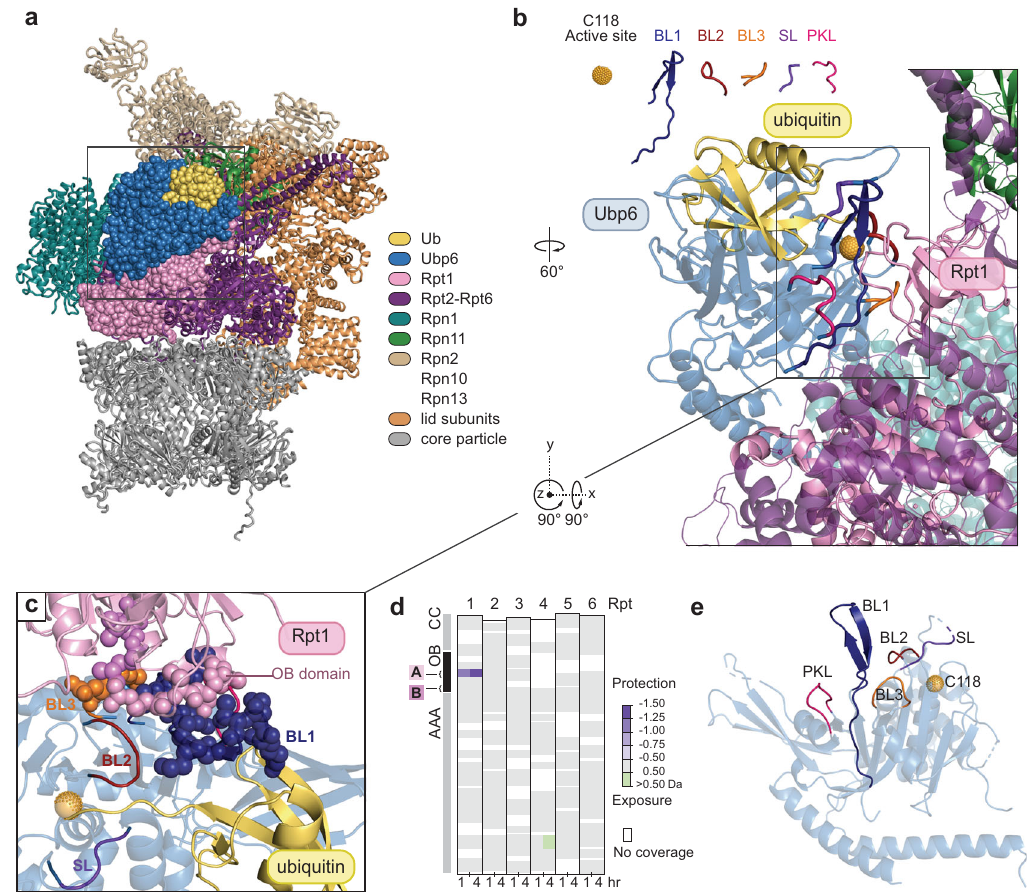
Fig. 1 Model of the Ubp6-Rpt1 interface. a Model of the Ubp6-UbVS-proteasome complex based on cryo-EM analysis. Ubp6, Rpt1, and ubiquitin are highlighted as spheres, other proteins as ribbons. Rpn1, teal; Rpn11, green; Rpn10 and other base subunits, tan; lid components, light brown; ATPases other than Rpt1, purple; core particle, gray. Boxed region is rotated and enlarged in b . (PDB: 7QO3, 7QO4). b Detail of Ubp6-Rpt1 interface with key features of Ubp6 highlighted. c Enlarged underside view of the Ubp6-Rpt1 interface with mutagenized residues rendered as spheres. Interface A is in blue for Ubp6 and pink for Rpt1; Interface B, orange for Ubp6, violet for Rpt1. d Interface A is protected from hydrogen exchange by the addition of excess Ubp6-UbVME. Ubp6-dependent deuteration differences within peptides of Rpt1-Rpt6 of puri fi ed regulatory particle are shown. See Supplementary Fig. 5 for additional HDX-MS data. All deuterium uptake values used to generate these difference maps can be found in Supplementary Data 1. e Critical loops of free Ubp6 (PDB: